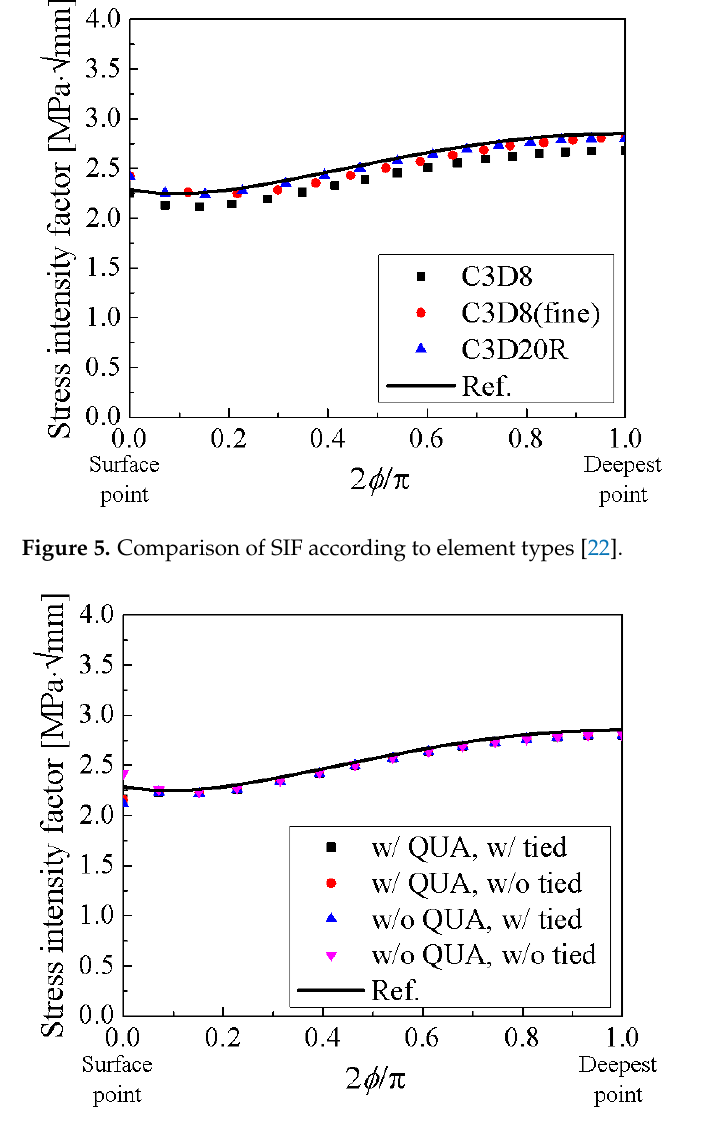
Figure 6. Comparison of SIF according to crack tip element characteristics [22] .